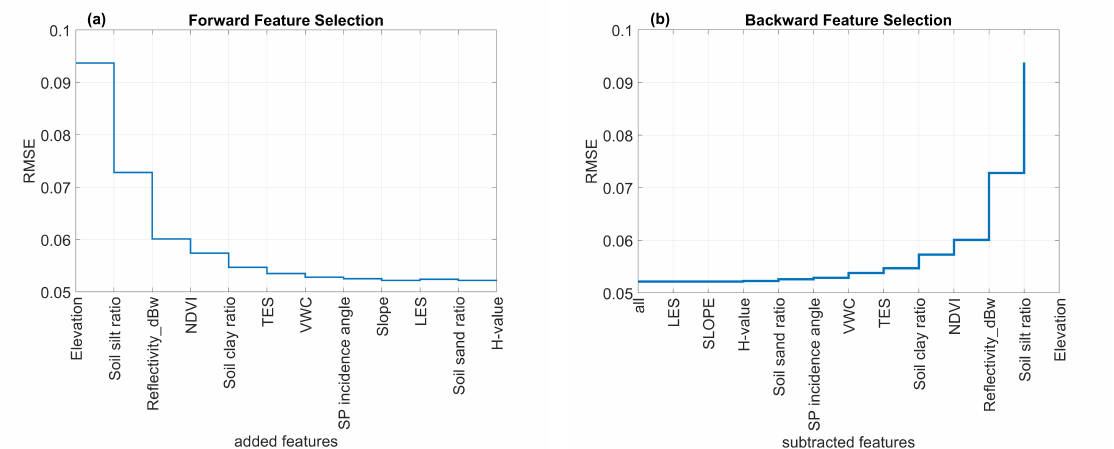
Figure 5. The RMSE values of the sequential feature selection through ( a ) forward and ( b ) backward selection